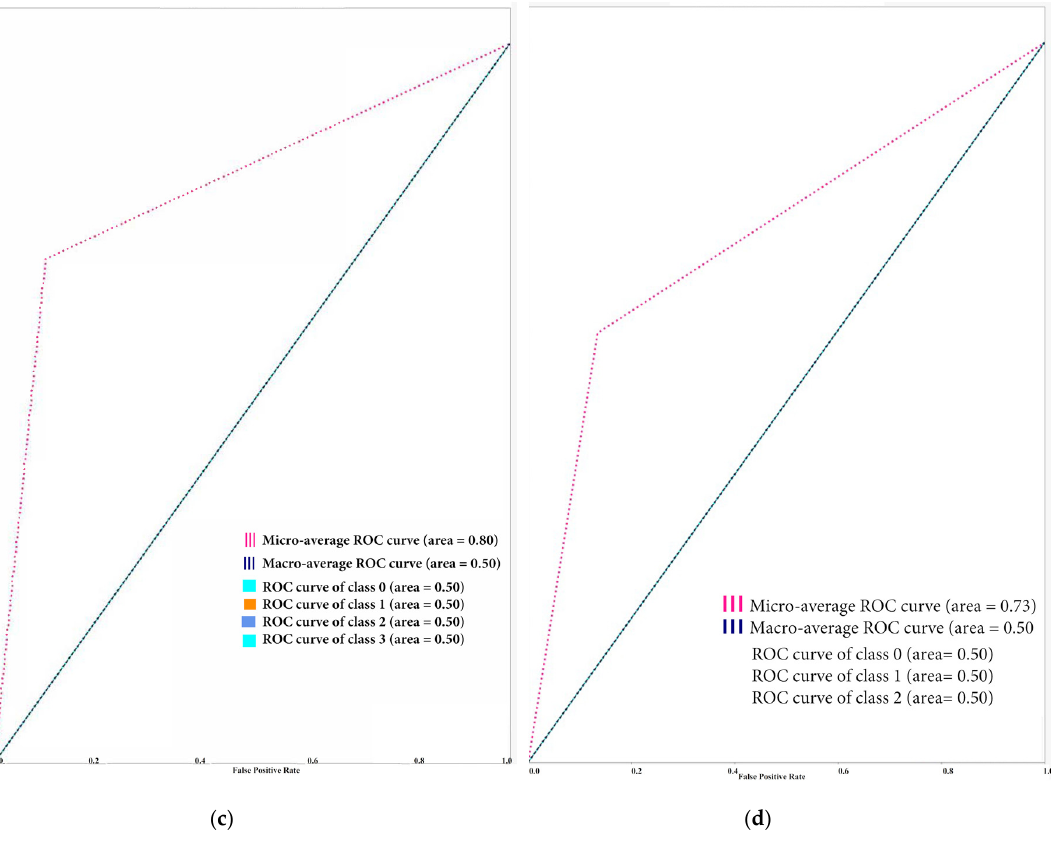
Figure 8. Receiver Operating Characteristic (ROC) curve: ( a ) ROC curve of model1_CF10 before novel class arrival ( b ) ROC curve of model1_CF10 after novel class arrival ( c ) ROC curve of model2_SD before novel class arrival ( d ) ROC curve of model2_SD after novel class